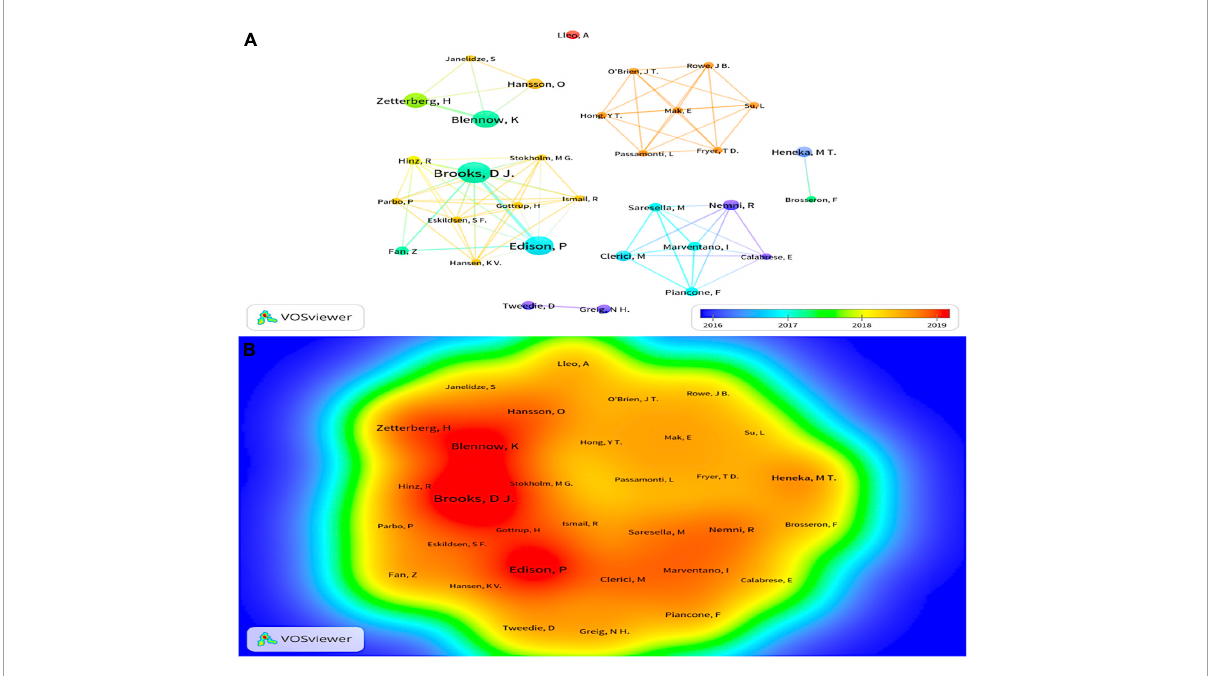
FIGURE4 (A) The cluster visualization map of cited authors created using VOSviewer from 2016 to 2019, (B) the density visualization map of cited authors created using VOSviewer. Node size and color represents total number of citations and a single time slice, respectively. The darker the color, the more